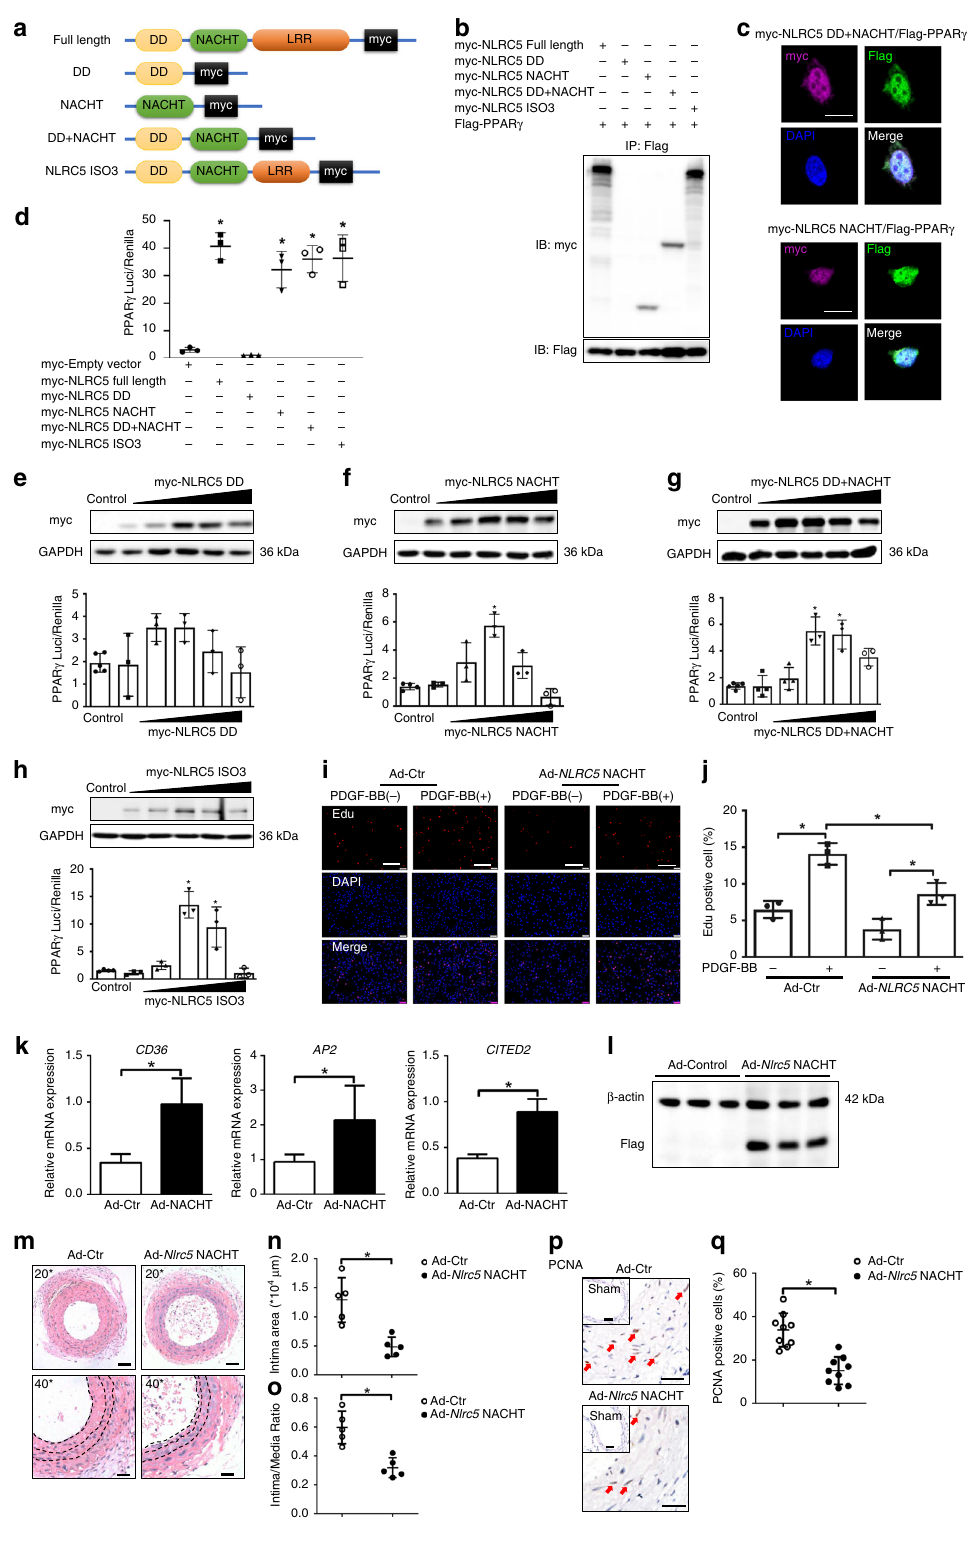
vs. Ad- Nlrc5 NACHT 0.48 ± 0.17 × 10 4 μ m 2 , P < 0.01 by Stu- dent ’ s t -test) and intima/media ratios (Ad-Control 0.60 ± 0.11 vs. Ad-Nlrc5 NACHT 0.32 ± 0.07, P < 0.01 by Student ’ s t -test) in ligated carotid arteries were markedly decreased in Ad- Nlrc5 NACHT mice compared with Ad-Control mice (Fig. 6m – o). Immunohistochemistry analysis of PCNA-positive cells within